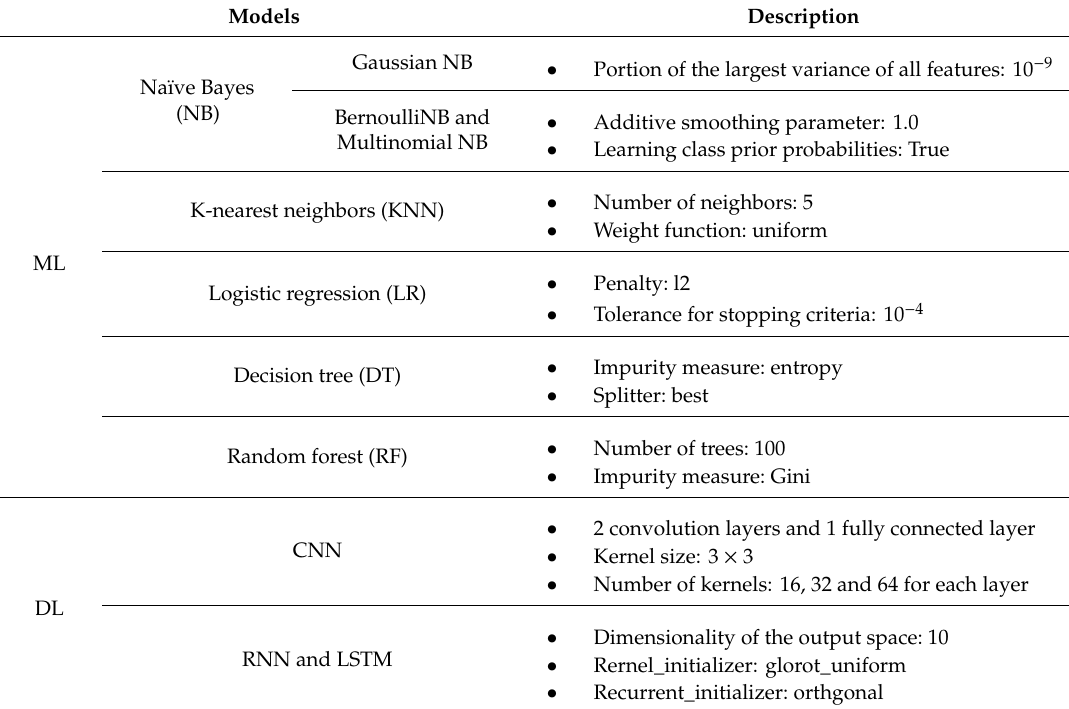
Table 8. Design of our ML and DL models.